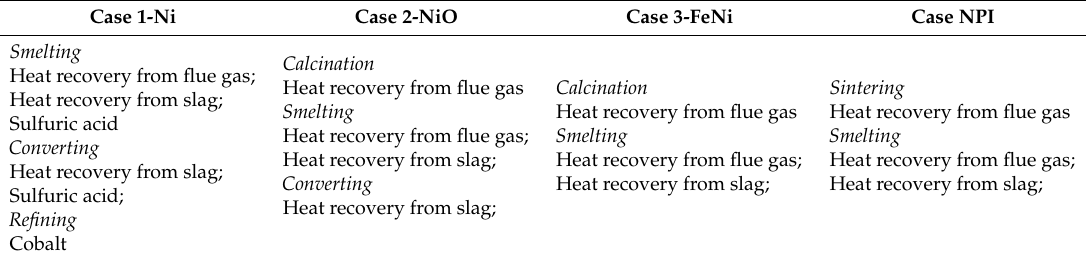
Table 11. Considered co-product allocation in the study.